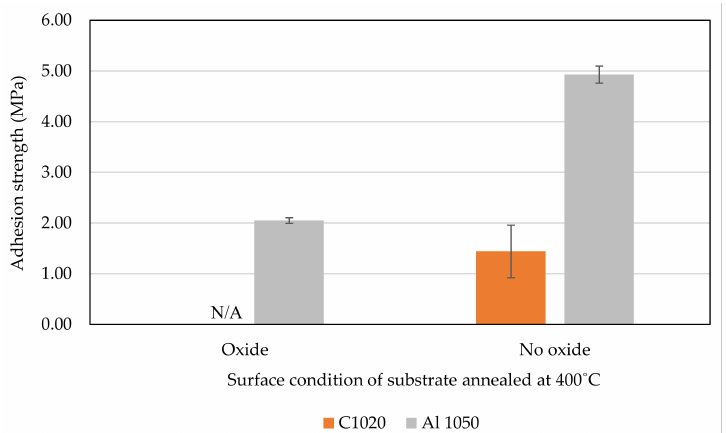
Figure 15. Cold-sprayed titanium dioxide coating bond strength on C1020 and AA1050 annealed at 400 ◦ C.